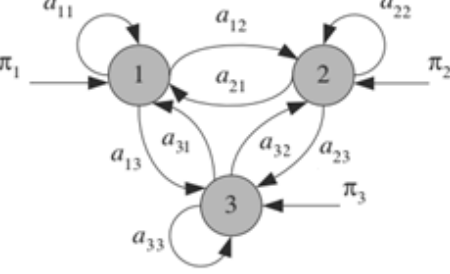
Figure 4. Stochastic automaton Representation of HMM.